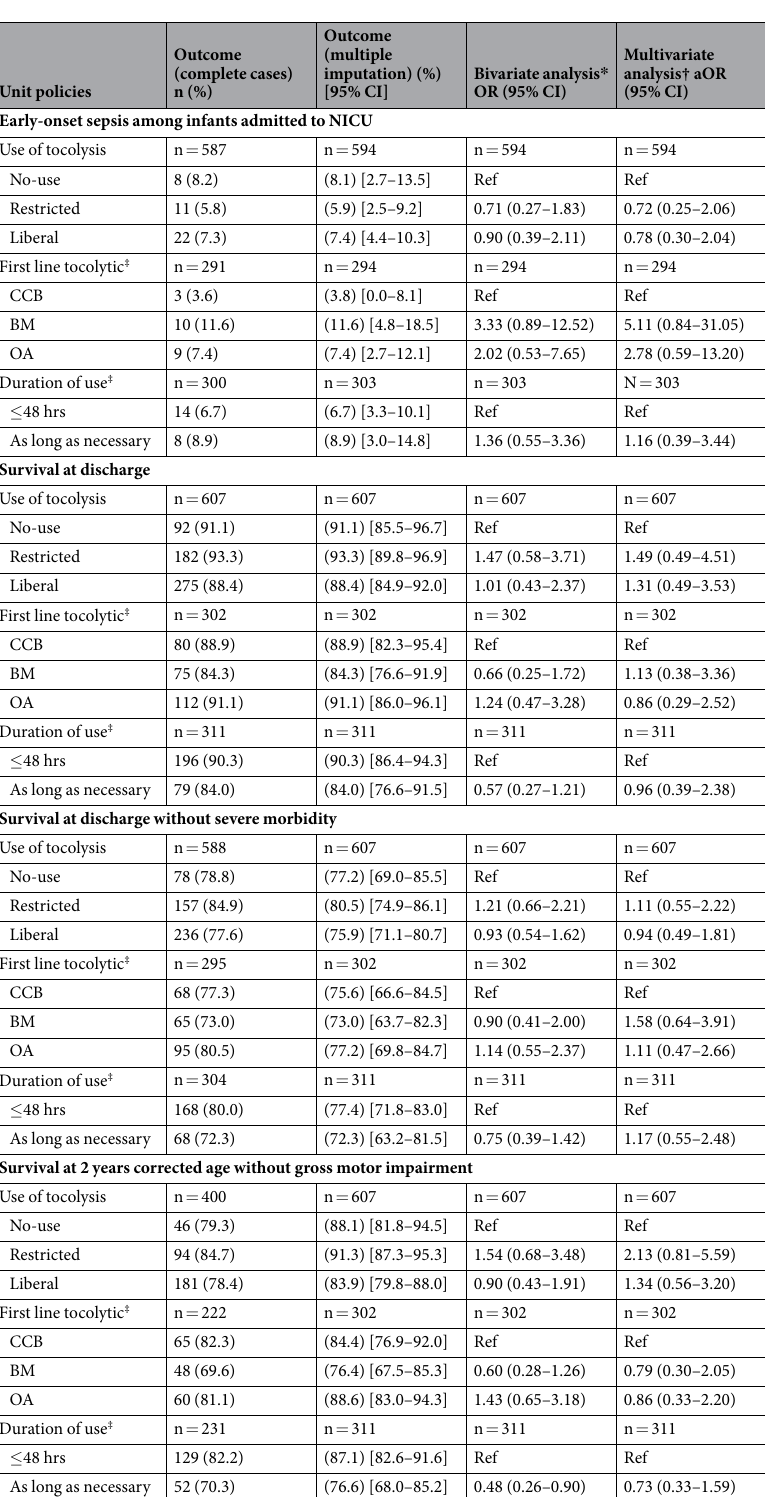
Table 4. Association of unit policy of tocolysis after PPROM and perinatal and 2-year outcomes. BM: Betamimetics, CCB: Calcium channel blockers, NICU: neonatal intensive care unit, OA: Oxytocin antagonists, OR: odds ratio, aOR: adjusted odds ratio. * Multilevel random-effect logistic regression with maternity unit as level 2 and country as level 3. Multiple imputation. † Multilevel random-effect logistic regression with maternity unit as level 2 and country as level 3, adjusted for unit characteristics (number of births in 2011) and individual characteristics (gestational age at PPROM). Multiple imputation. ‡ Among units with a liberal policy for tocolysis after